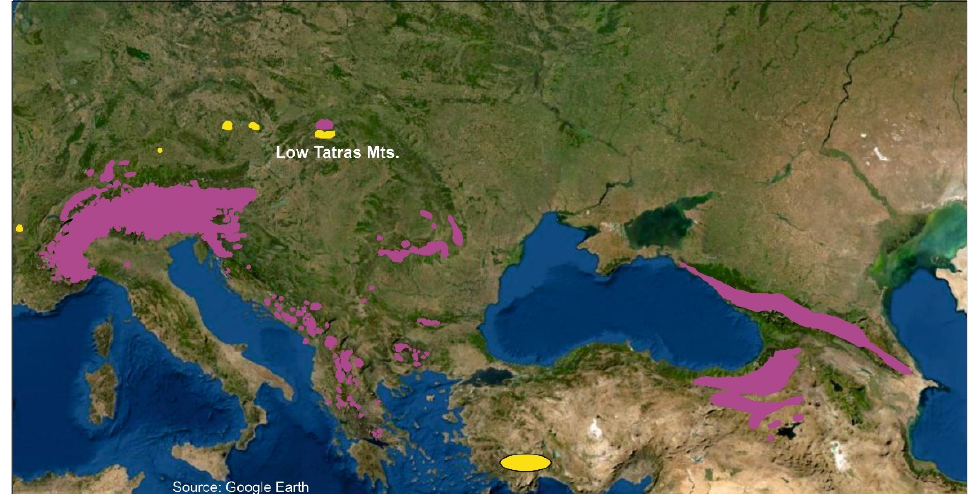
Figure 2. Natural distribution (violet colour) and introduction of chamois in the mountains of Central Europe (yellow colour). (Based on: https://upload.wikimedia.org/wikipedia/commons/7/7f/Rupicapra_rupicapra.png (accessed on 24 August 2022)).